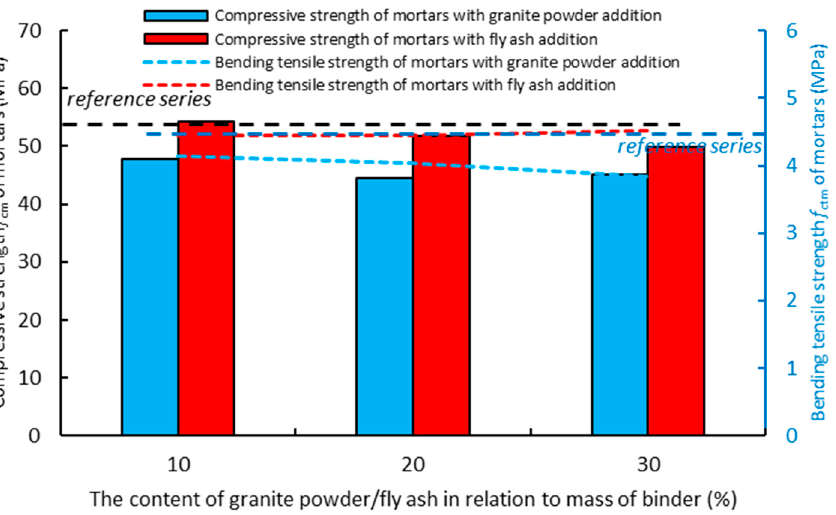
Figure 12. The effect of replacing the cement with the granite powder or fly ash on the compressive strength (fcm) and bending tensile strength (fctm) of the air-cured hardened cementitious composites after 90 days.